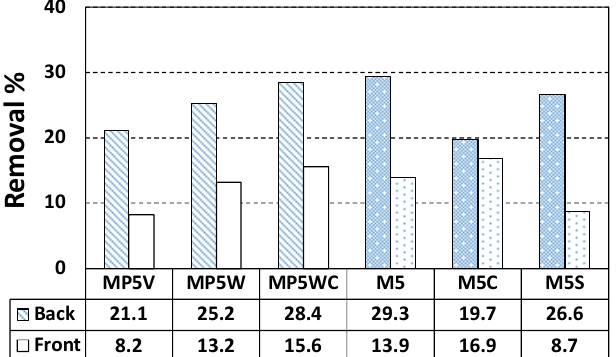
Figure 9. NO removal % by mortar (5 wt % TiO 2 ) with and without ultra-sonication and dynamic compaction after casting (C: with compaction, S: with ultrasonication).